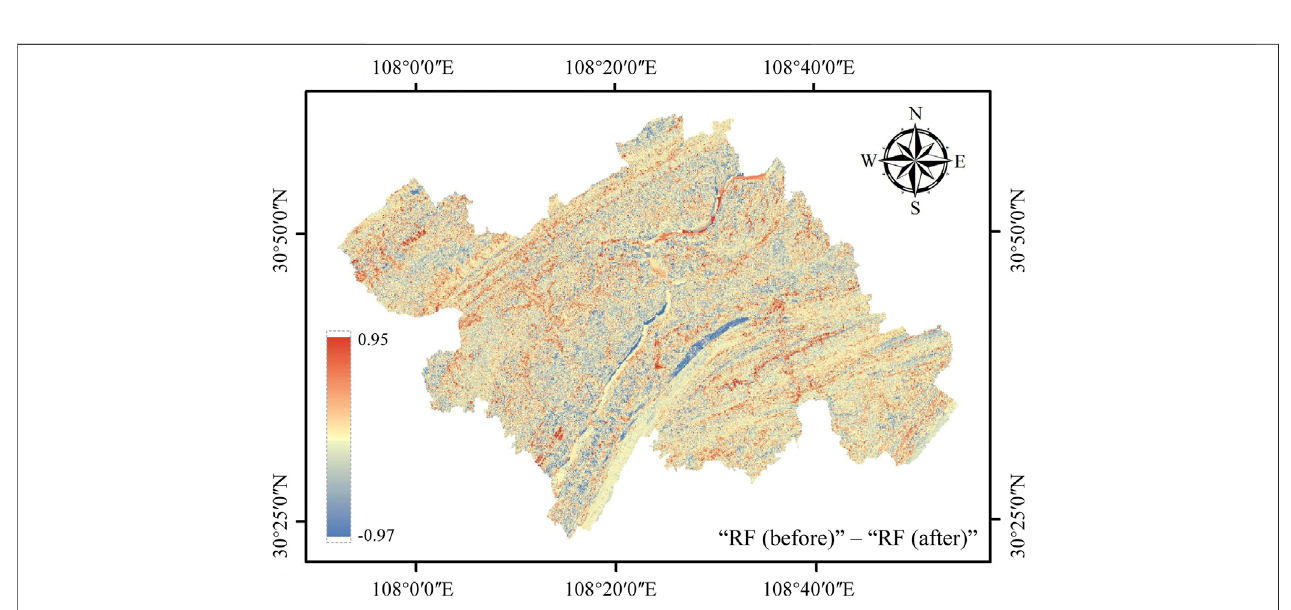
FIGURE 9 | Comparison map of original and improved LSM based on the RF model.